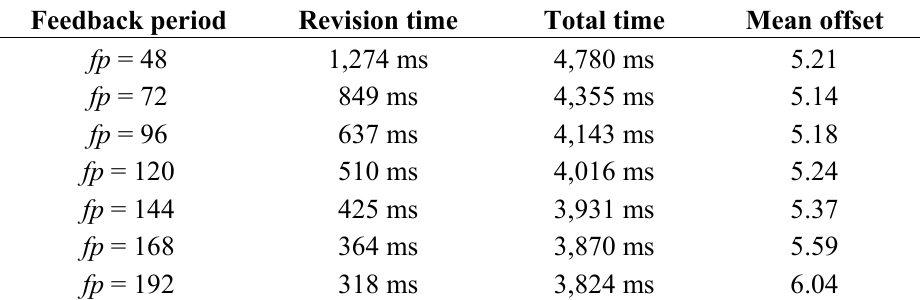
Table 5. Tracking accuracy and time consumption for different FZT feedback